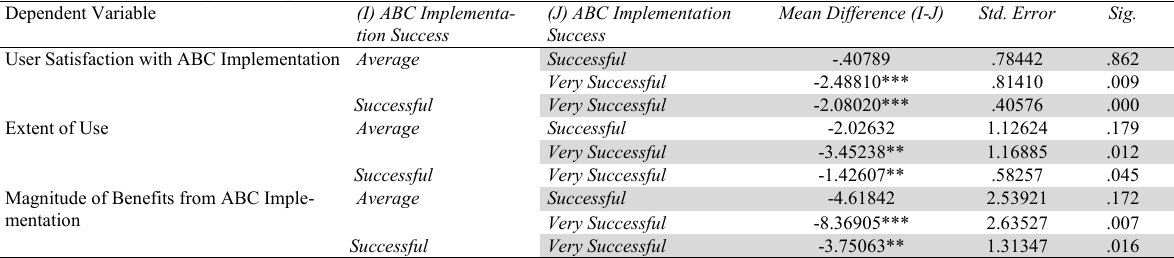
Post Hoc Tests (Multiple Comparisons) - Aggregated Variables Dependent